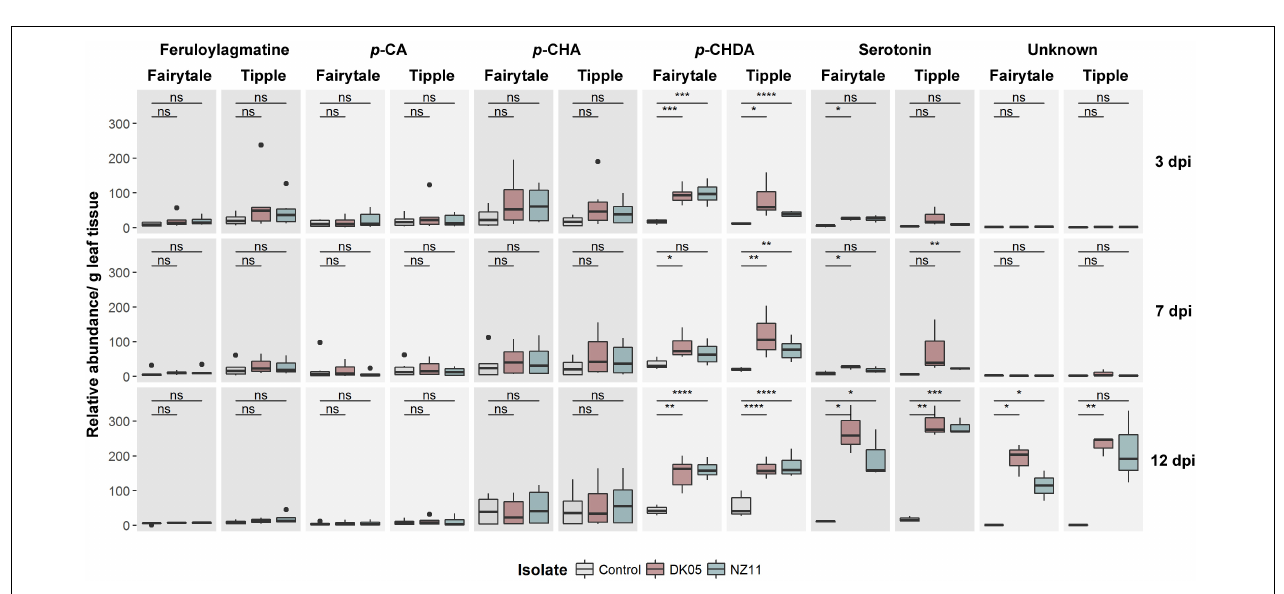
FIGURE 6 | Stacked relative bar plots depicting the proportions of significant enriched GO terms in the identified gene co-expression modules. GO-terms were filtered and superior GO-terms [as biological process (bp), cellular component (cc), and molecular function (mf)] were removed. Gene modules and associated bars are sorted by a hierarchical clustering represent by the dendrogramm. Name of module is presented inside the bar. The number corresponds to the number of genes left inside the module after removing the main GO terms.